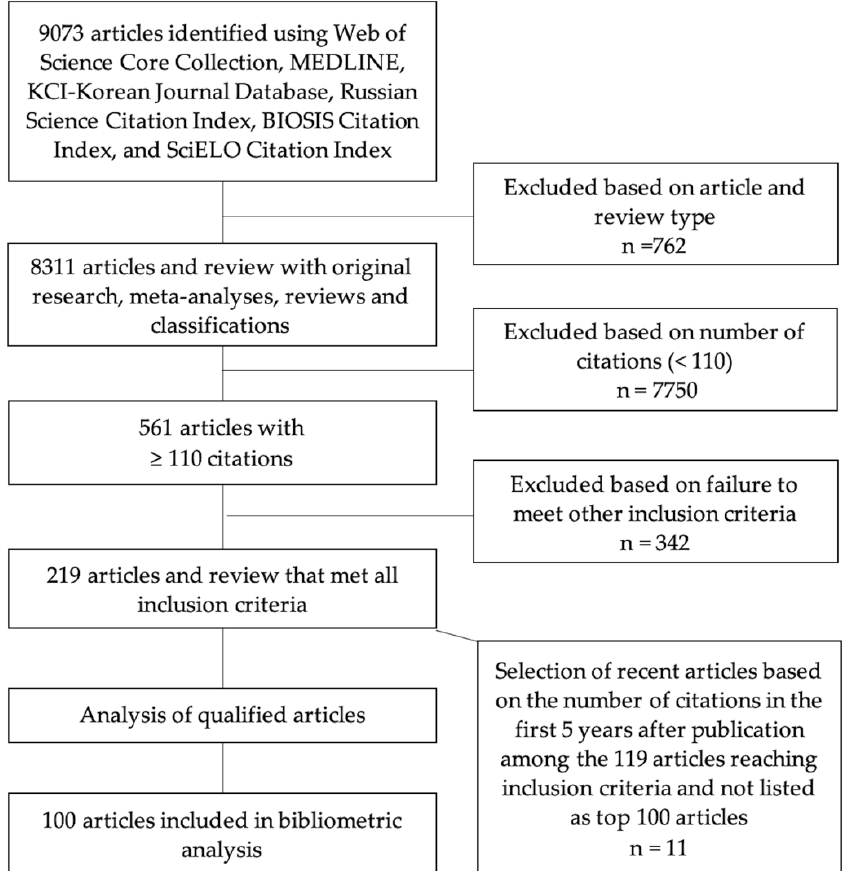
Figure 1. Flowchart illustrating the procedure of allocation of articles.